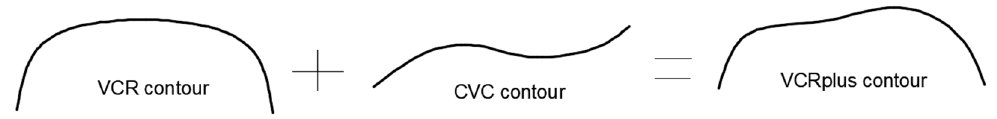
Figure 9. F2 stand work roll shifting position distribution.